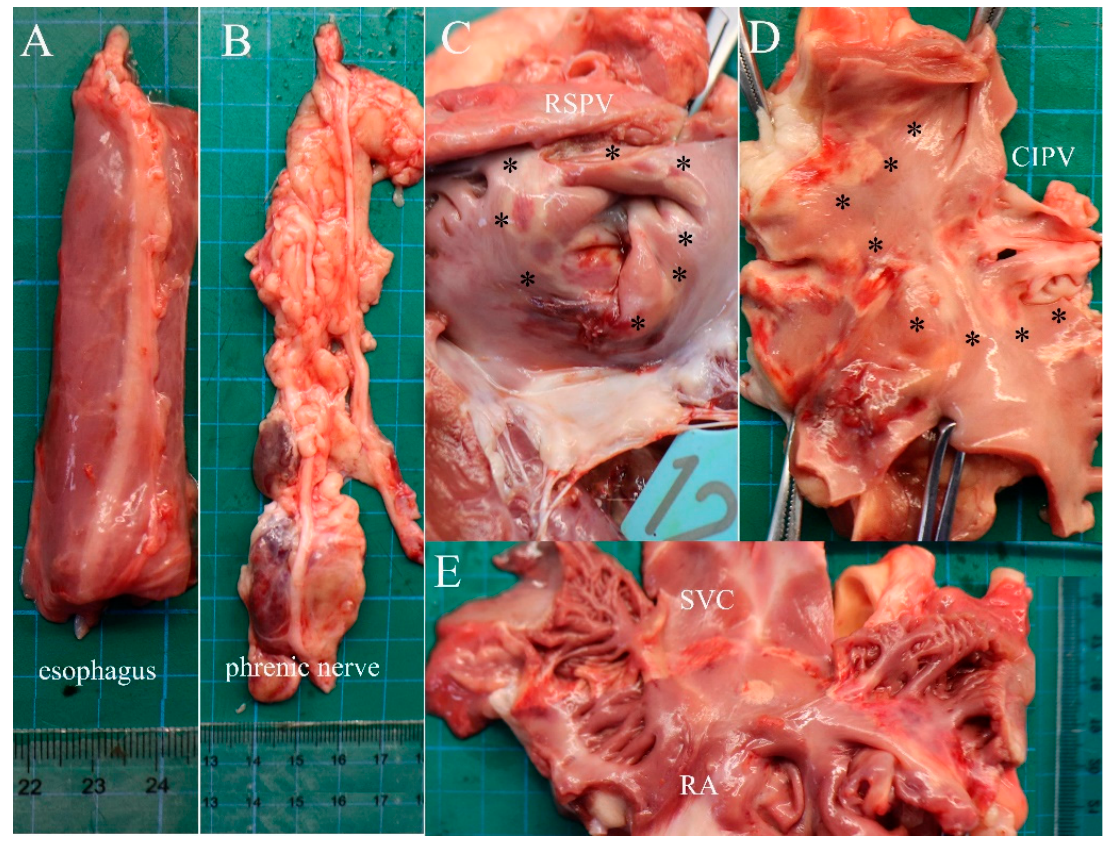
Figure 6. Pathology. ( A ) Outer esophagus. ( B ) The outer phrenic nerve. ( C – E ) Internal aspect of the transmural lesions in the RSPV, CIPV, and SVC. Asterisks indicate the ablation area.